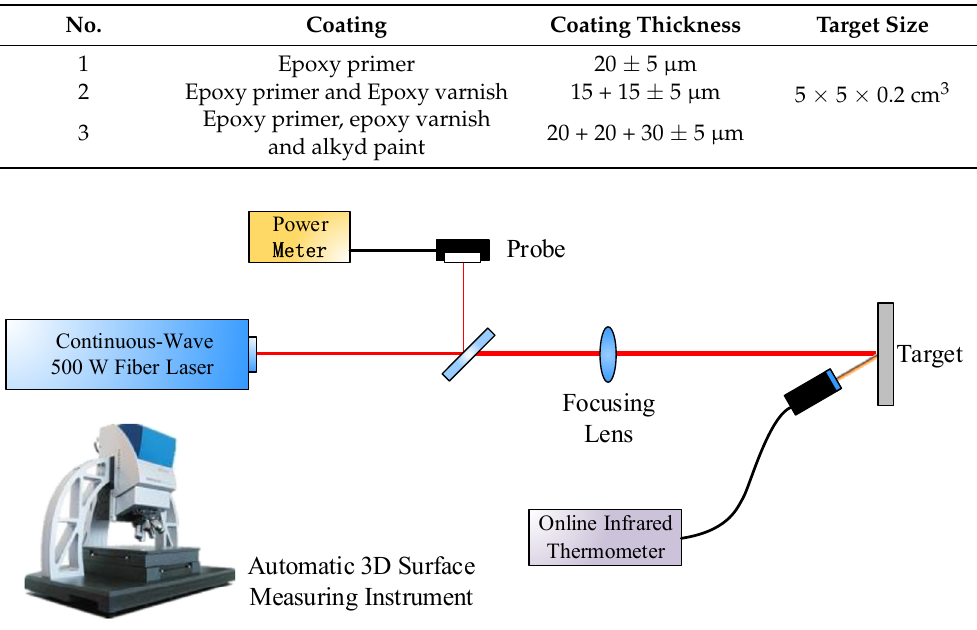
Figure 1. Schematic laser cleaning. The ablation depth was measured according to international practice ISO5436. Five repeated experiments were conducted for each parameter. To highlight the change rule of removal depth with power density, the continuous laser action time was 1 s.